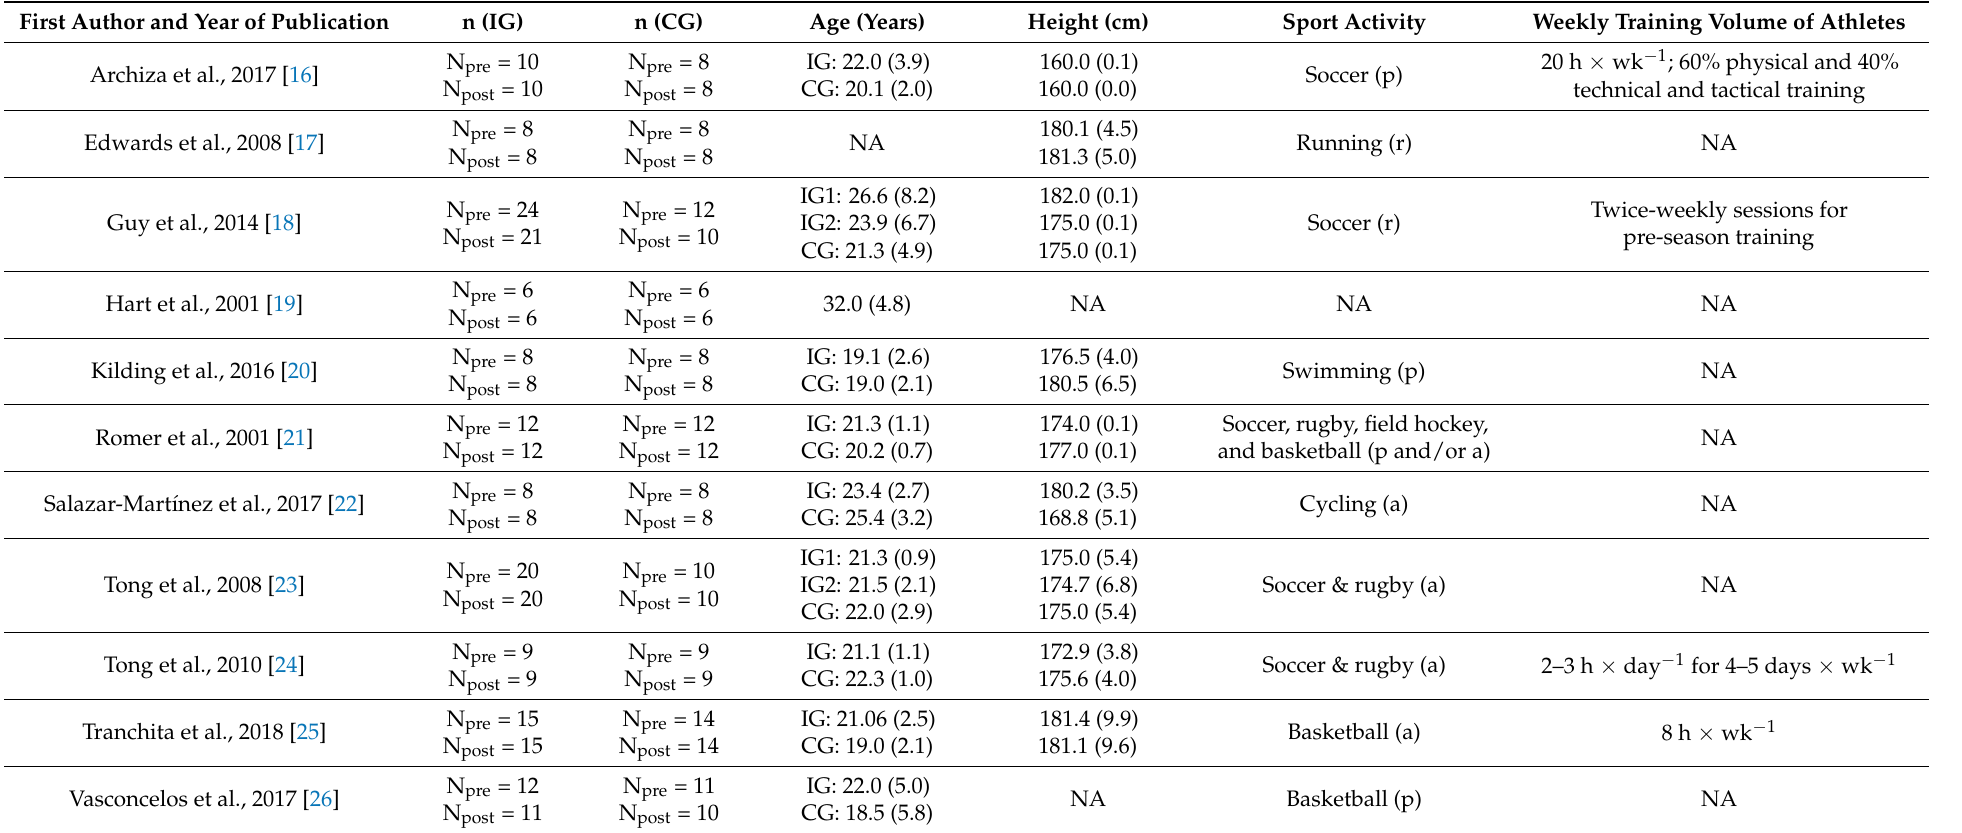
Table 1. Characteristics of participants in the selected